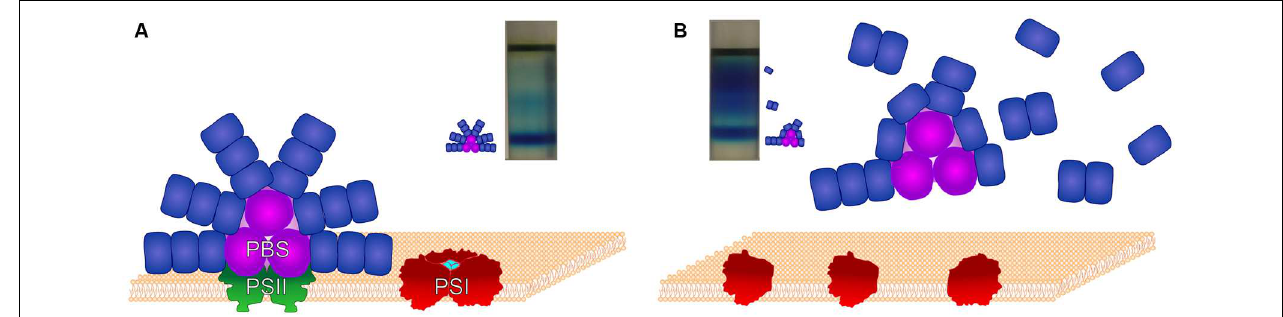
FIGURE 2 | The structures of PBS and the photosynthetic reaction centers in wild-type Synechocystis and its (cid:49) crtB carotenoid-less mutant. Schematic figure showing the assembled supercomplexes and the positions of their constituents following separation by stepwise sucrose density gradient centrifugation. (A) : Fully assembled functional supercomplexes of wild-type cells with entire PBS, dimeric PSII and trimerized PSI. (B) : Monomeric PSI and partially assembled PBS of the (cid:49) crtB mutant. In these cells only a negligible amount of PSII is formed.